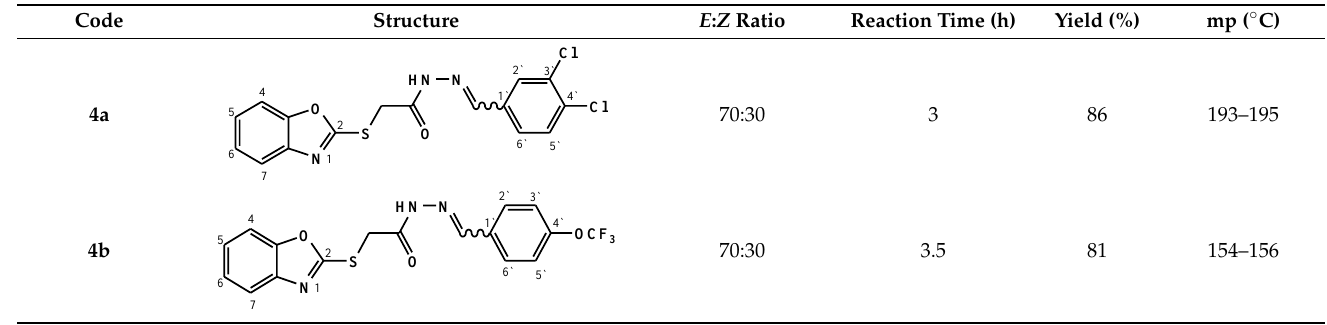
Table 1. Structures, E:Z ratios, reaction times, yields, and melting points of the synthesized compounds, 4a – 6b. Code Structure E : Z Ratio